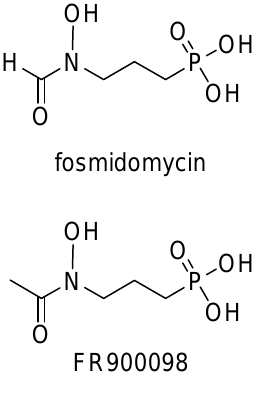
Figure 15. Chemical structures of fosmidomycin and